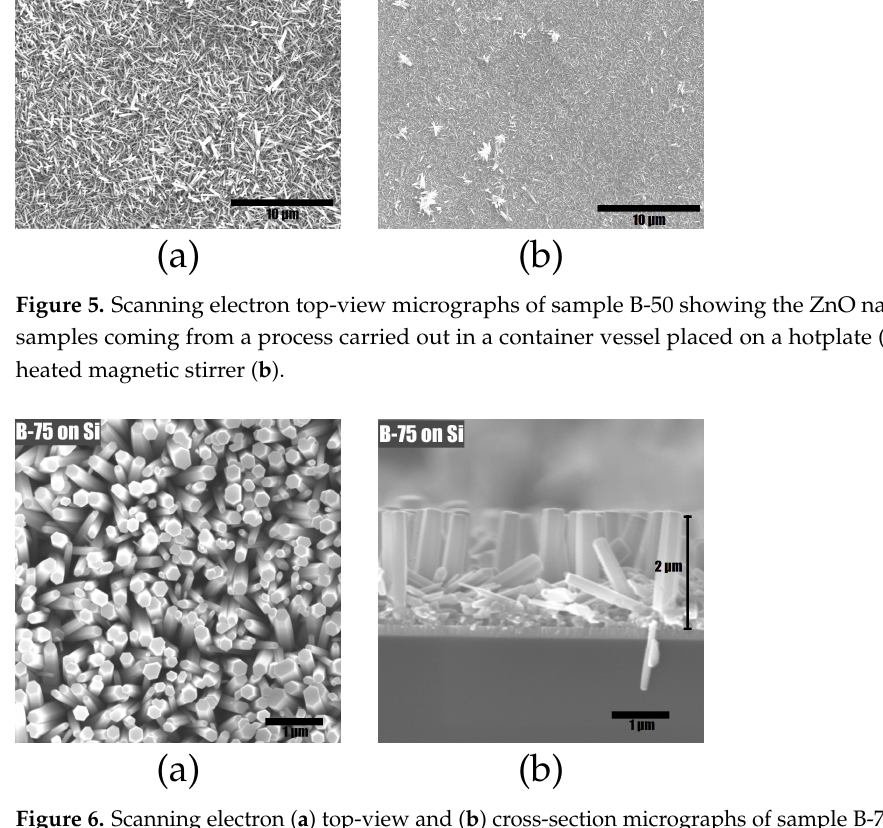
Figure 6. Scanning electron ( a ) top-view and ( b ) cross-section micrographs of sample B-75 deposited on silicon.